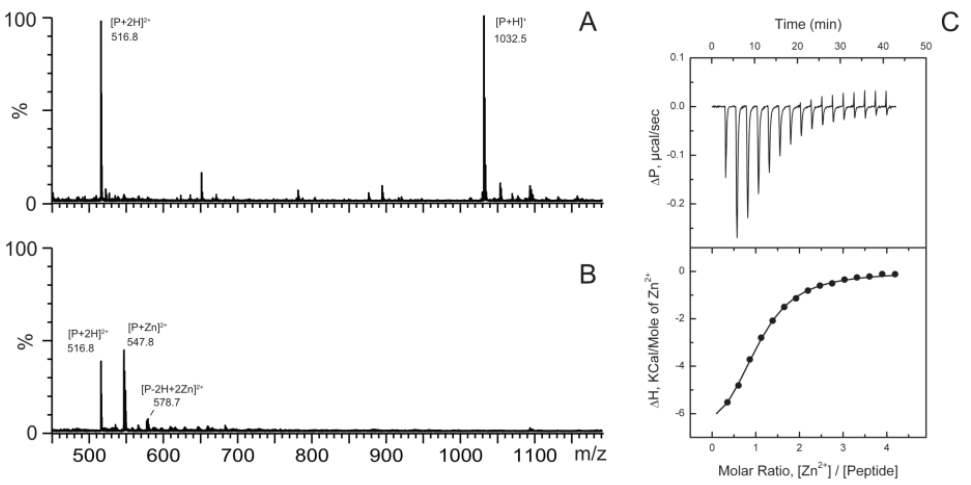
Figure 2. The 450–1200 m / z range of the positive ion mass spectra obtained for 10 µM ALR peptide in 100 mM ammonium acetate buffer in the absence ( A ) in the presence ( B ) of 50 mM ZnCl 2 , pH 7.3. Major signals at m / z 516.8, and 1032.5 correspond to the single and double charged molecular ion of the ALR peptide (marked as P). In the presence of zinc signal at 547.8 and 578.7 m / z were detected, which correspond to ALR complexes with one and two zinc ions. ( C ) Typical ITC titration curve (upper panel) and binding isotherm (lower panel) for zinc interactions with ALR peptide at 25 °C in 50 mM Tris buffer, pH 7.3.